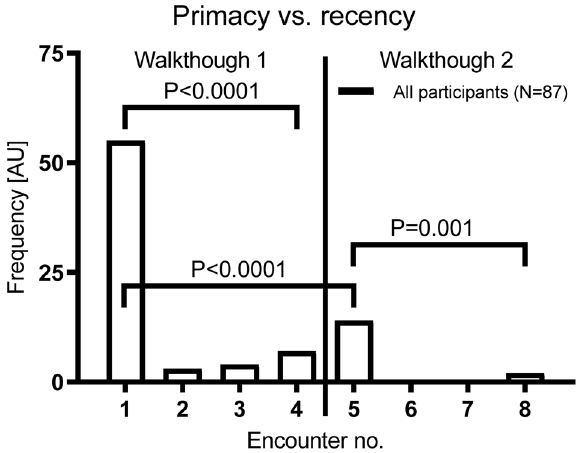
Figure 4. Primacy and recency position effects across all participants of the online study. Frequency distribution of a specific encounter (person target stimuli) spontaneously remembered. Encounter no. 1 refers to the first person encountered during the passive walkthrough 1 while encounter no 8 refers to the last person encountered during passive walkthrough 2. Bars represent the median and interquartile range [Mdn + IQR] of the frequency of the reported encounter. P -values given refer to Wilcoxon signed rank tests for dependent